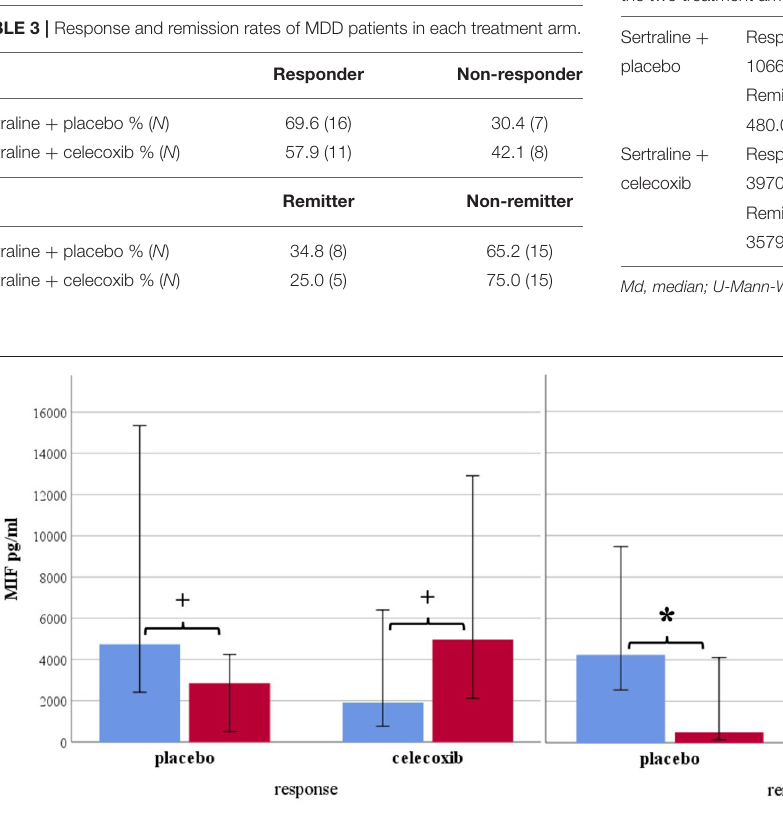
FIGURE 1 | Macrophage migration inhibitory factor levels at baseline according to response and remission status. Median levels are displayed in pg/ml; 95% confidence interval error bars are displayed; placebo sertraline plus placebo group; celecoxib sertraline plus celecoxib group. * p < 0.05 and + p < 0.10.